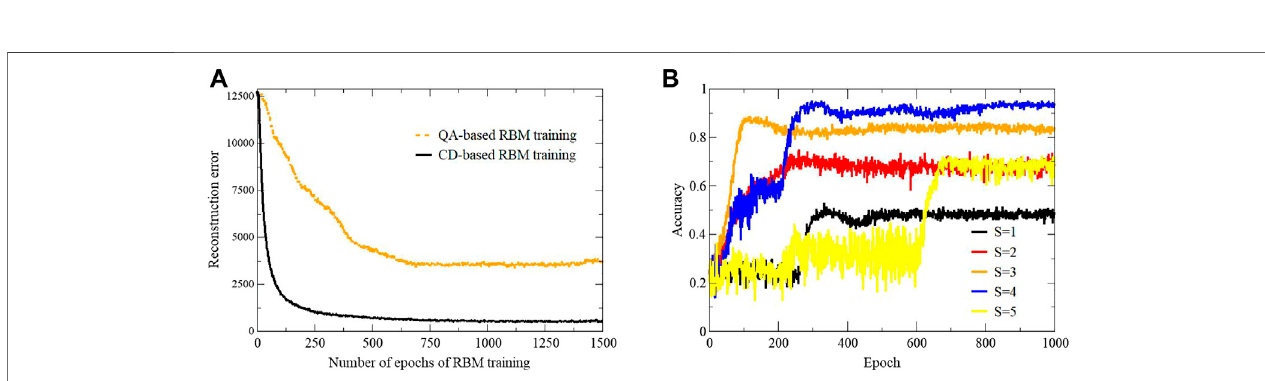
FIGURE 4 | (A) Reconstruction error versus epoch of the RBM training. (B) The plot of the classi fi cation accuracy versus epoch for different values of the hyperparameter S .